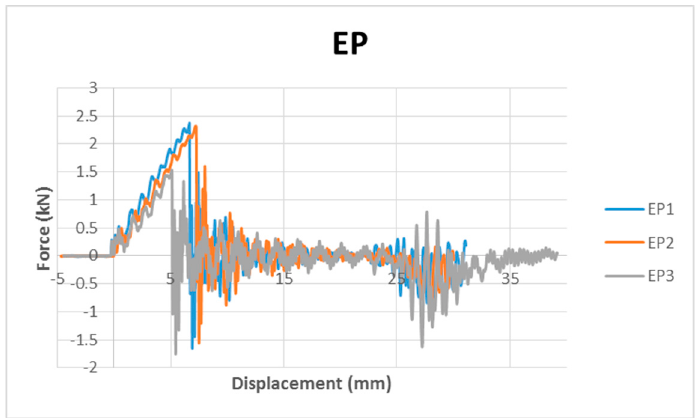
Figure 2. Force displacement graphs of EP at a 15 J impact energy level showing open curves indicating full penetration.